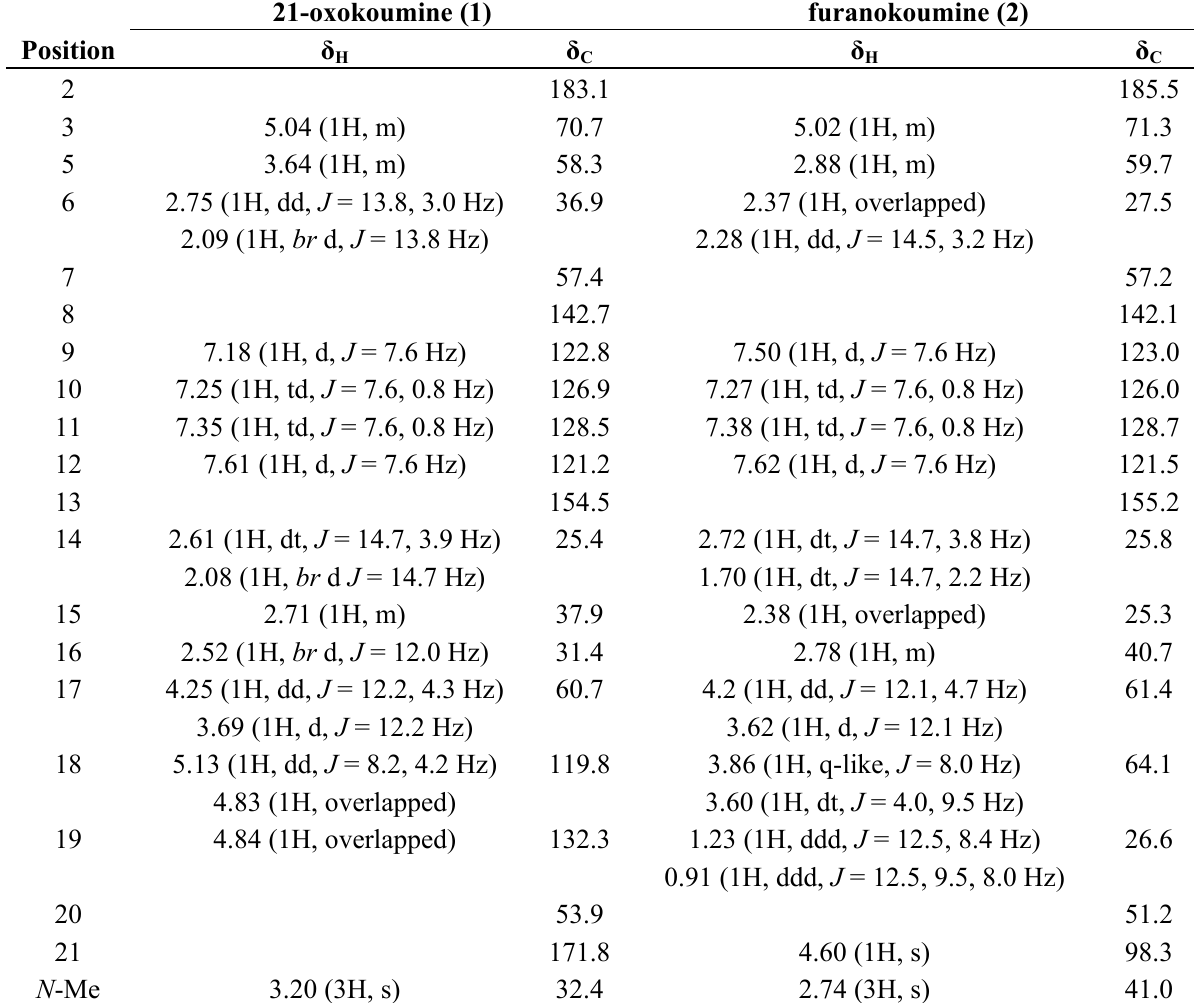
) spectroscopic data of 1 and 2 . 3